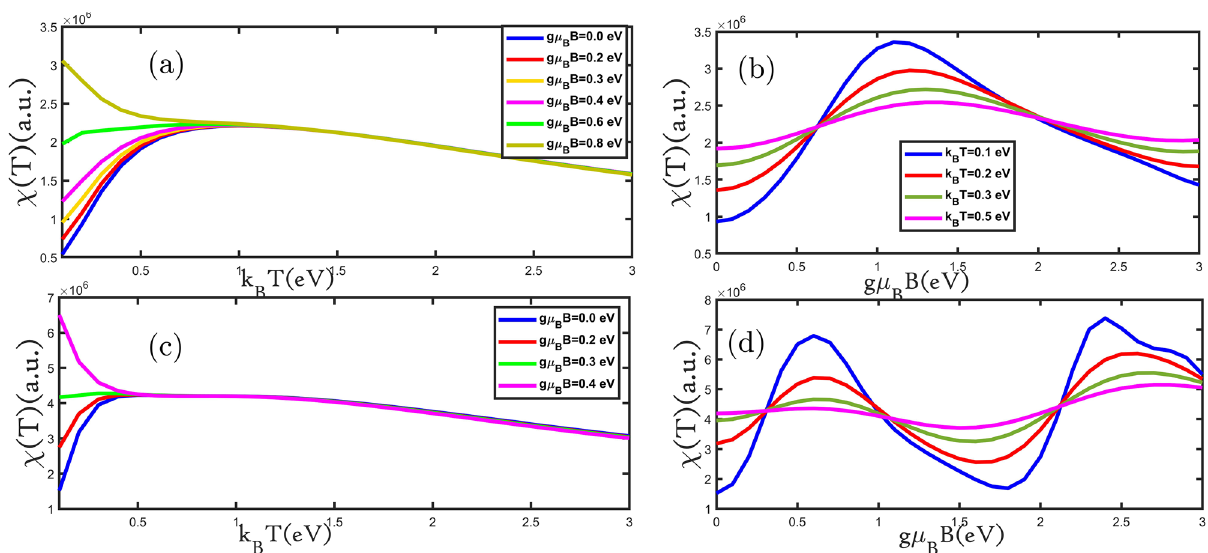
Figure 6. ( a – d ) the magnetic susceptibility as a function of the temperature (external magnetic field) for planar and buckled silicene monolayers in the presence of different external magnetic fields (temperatures),